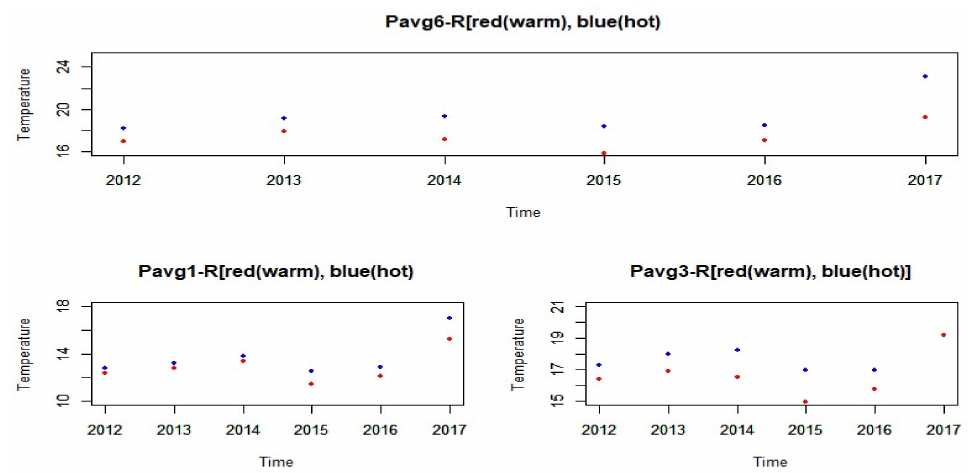
Figure 36. RCP 4.5 warm model (IPSL-CHEM-MR) and RCP 4.5 hot model (MIROC-ESM-CHEM) predictions for the period 2012–2017 (full dam steady-state), temperature in ◦ C.